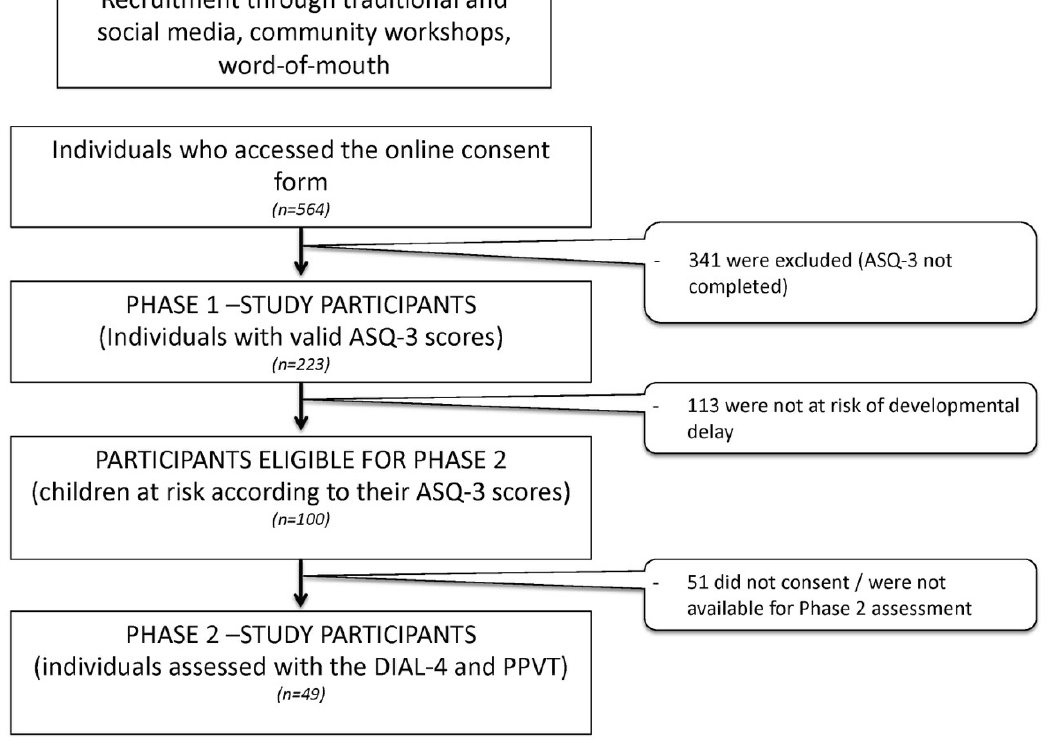
Figure 1. Flow chart of the recruitment process. Table 1. Parent and child sociodemographic information.